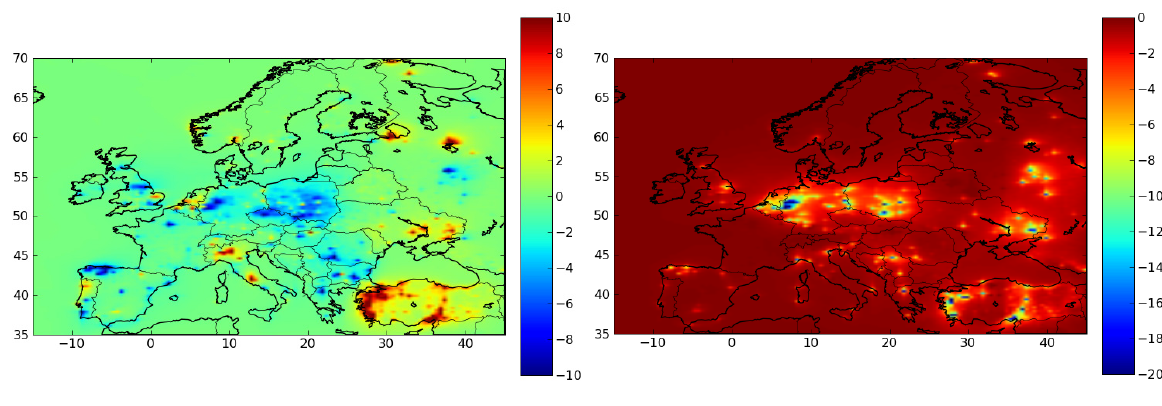
2030 for the Baseline scenario. Positive numbers indicate an increase and negative ones a reduction in the deposition levels. ( Right panel ) The difference in the Hg deposition over Europe in 2030 between the Baseline and the Maximum Renewable Power